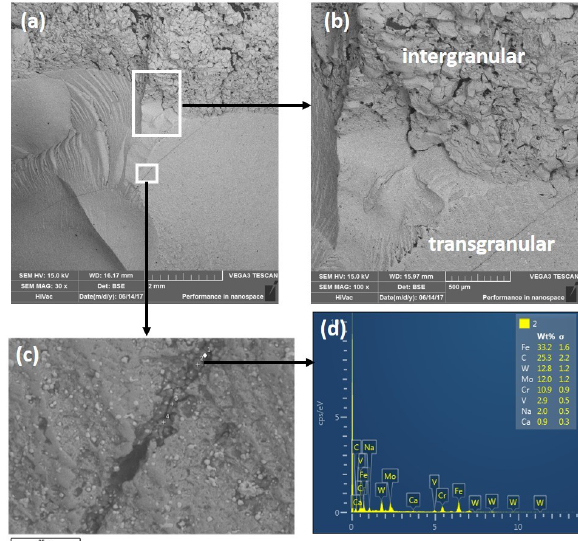
Figure 5: The boundary area between the fine and the rough surface